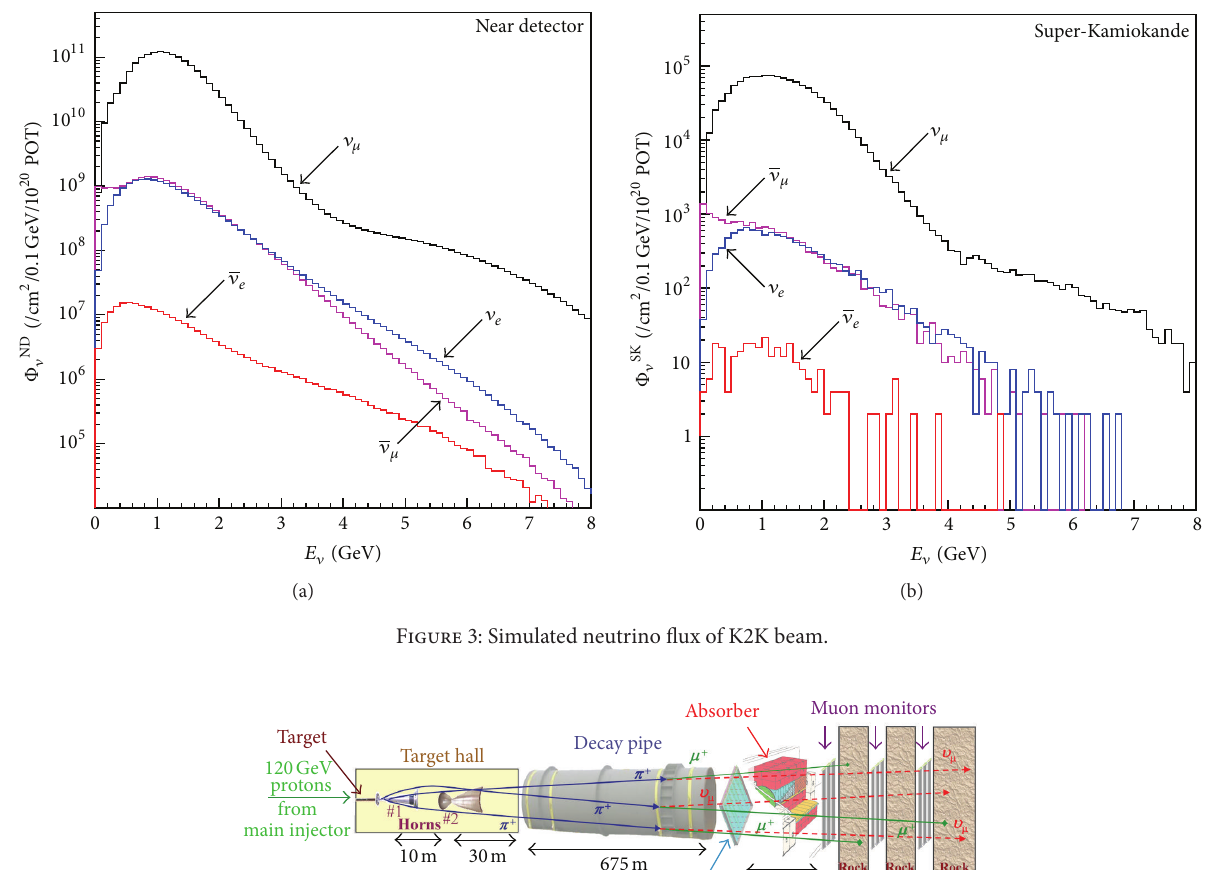
Figure 4: A schematic of the NuMI beamline. Protons from the Main Injector strike a graphite target, shown at the far left, and the resulting negatively or positively charged hadrons are focused by two magnetic horns. A 675m long decay pipe gives the short-lived hadrons and muons time to decay. All hadrons remaining at the end of the decay volume are stopped by the absorber leaving just muons and neutrinos. The remaining muons are stopped by nearly 250m of rock. Figure from